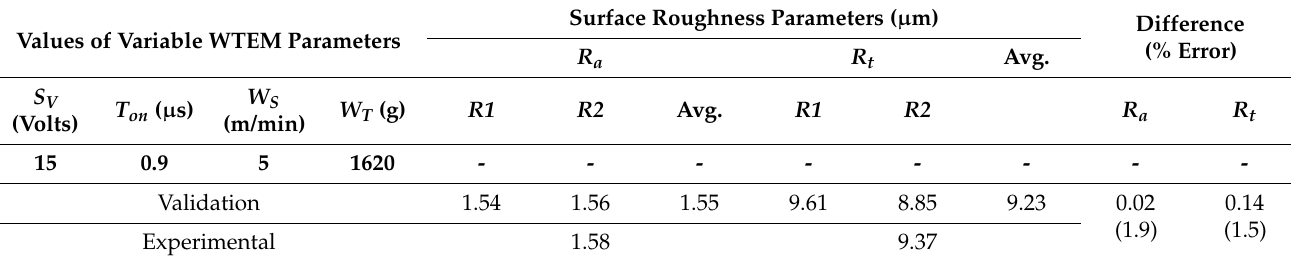
Table 2. Results of validation experiments for the best finish miniature gear manufactured by WTEM. Values of Variable WTEM Parameters